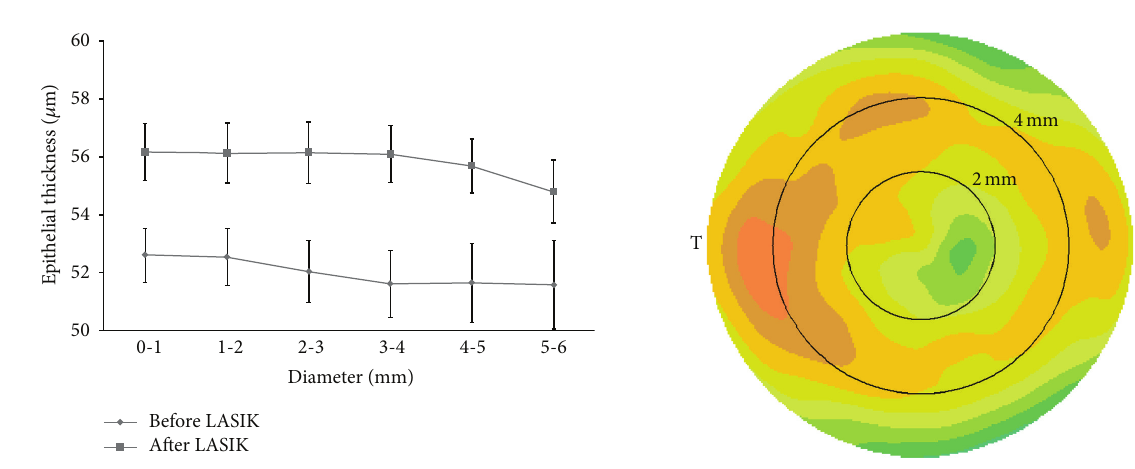
Figure 2: Corneal epithelial thickness before and 3 months after LASIK. Error bar denotes the standard error of the mean, 𝑝 < 0.01 at all diameters.